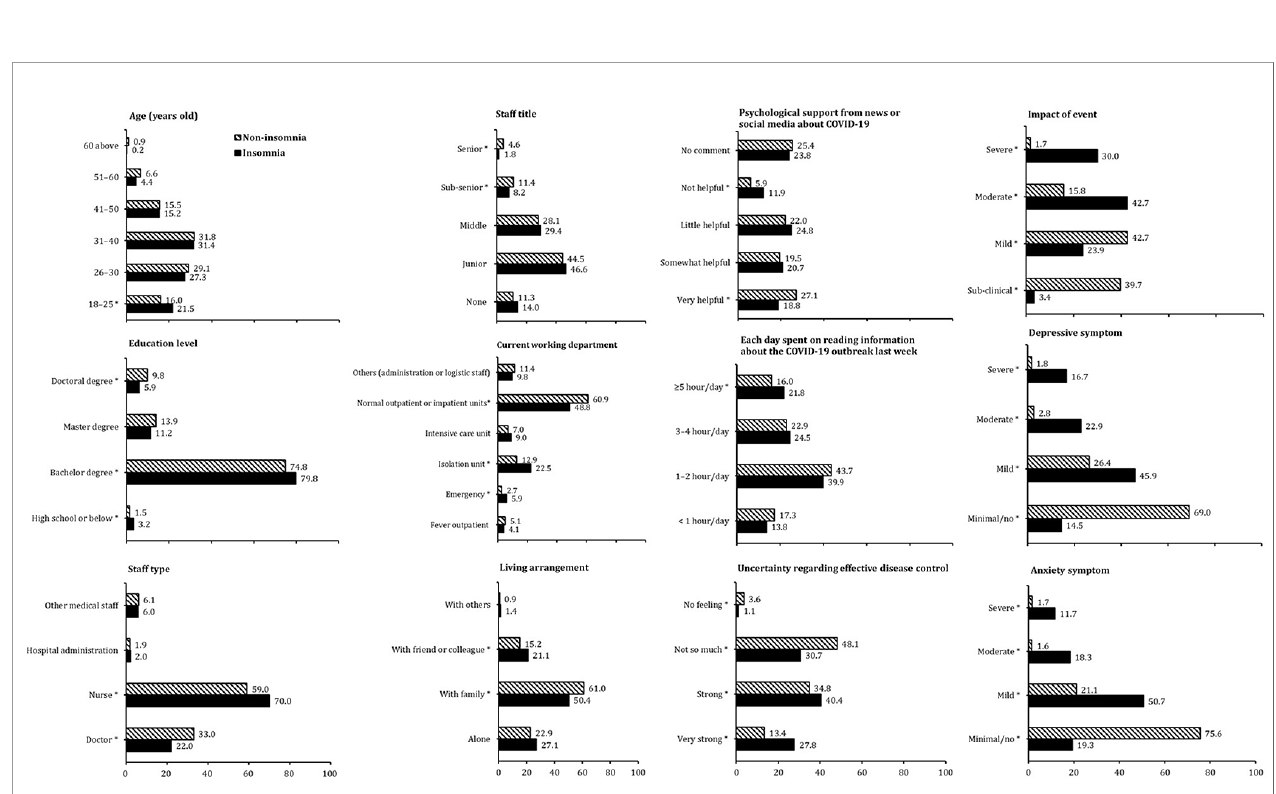
FIGURE 2 | Post hoc analyses of multiple comparisons between the insomnia and non-insomnia group on demographic data, sociopsychological factors, and mood status, *Signi fi cance after Bonferroni